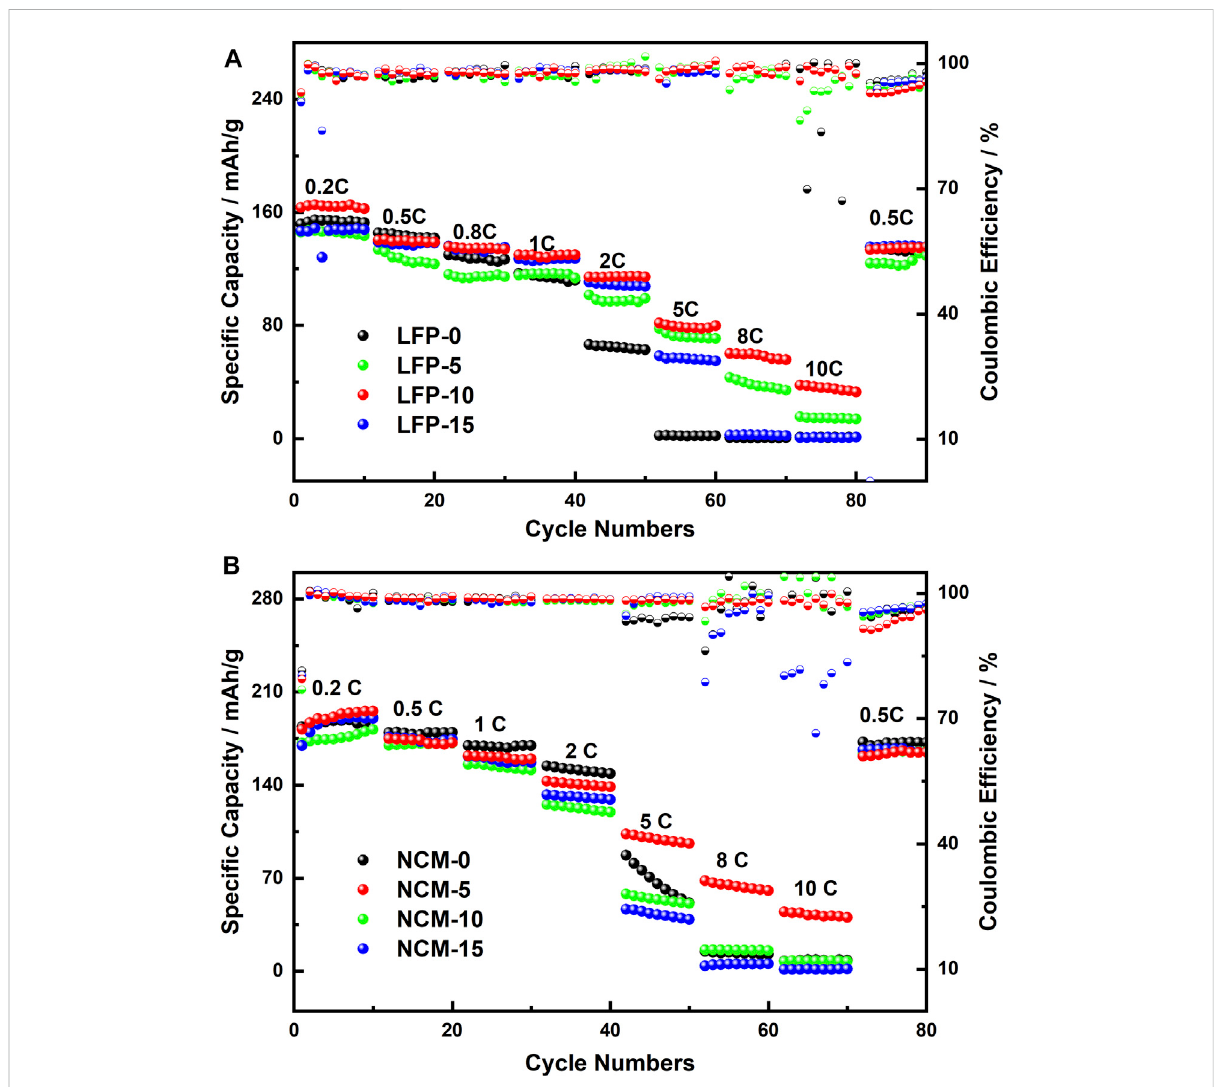
Rate performance of all samples: (A) LiFePO 4 ; (B)